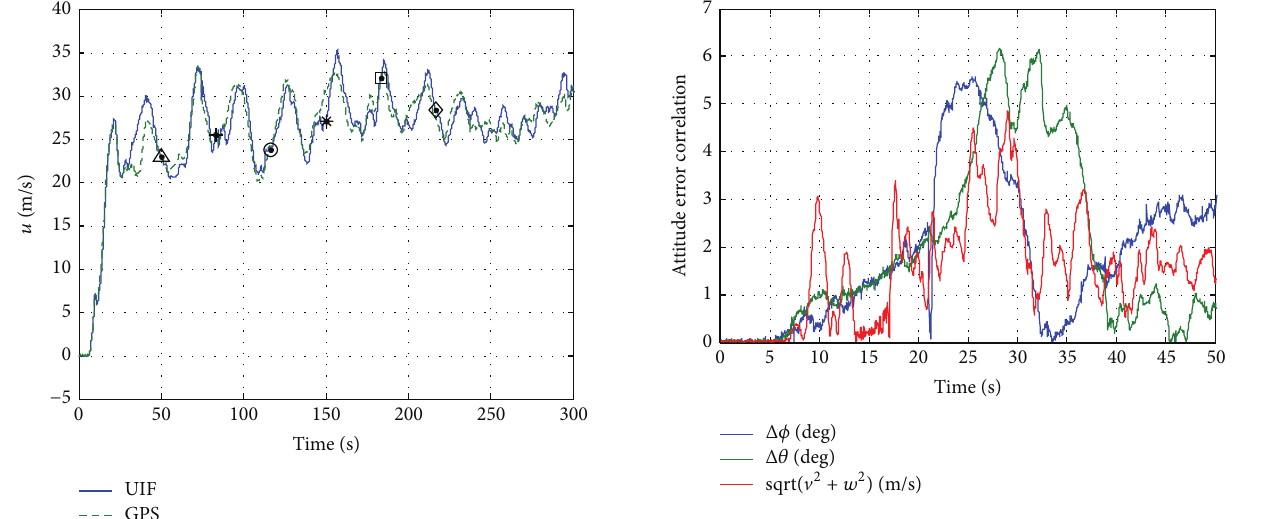
Figure10:SimplifiedformulationspeedestimationresultsforFlight #1.